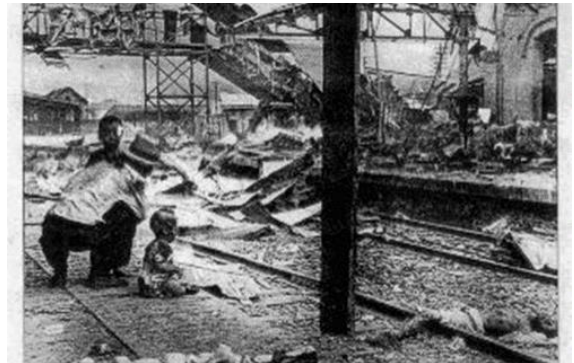
Figure 5. Rescue of baby Ping-Mei. Source: LOOK Magazine.